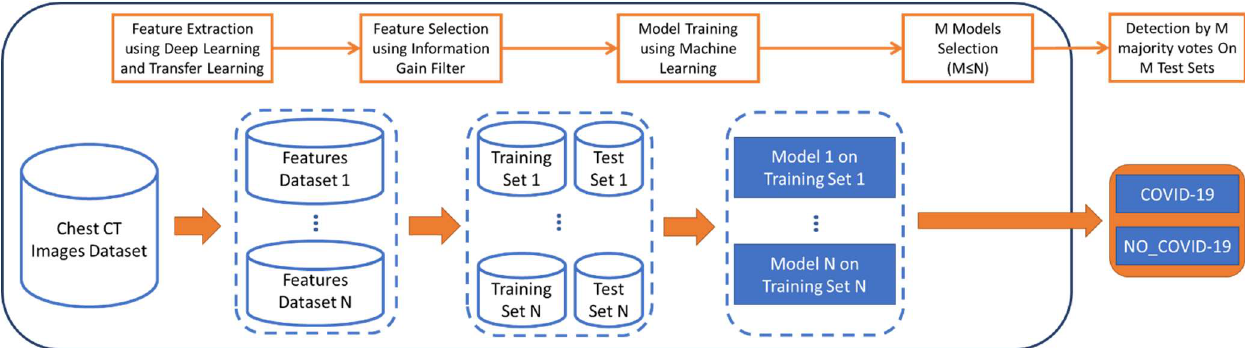
Figure 1. Summary of the pipeline used in this study.